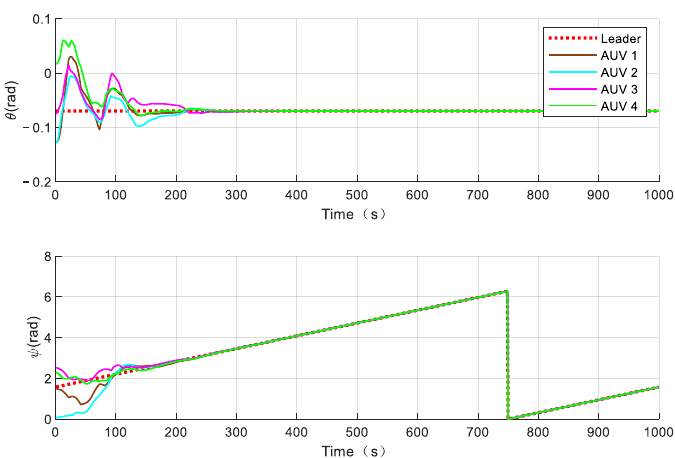
Figure 7. Attitude status of the AUV formation.